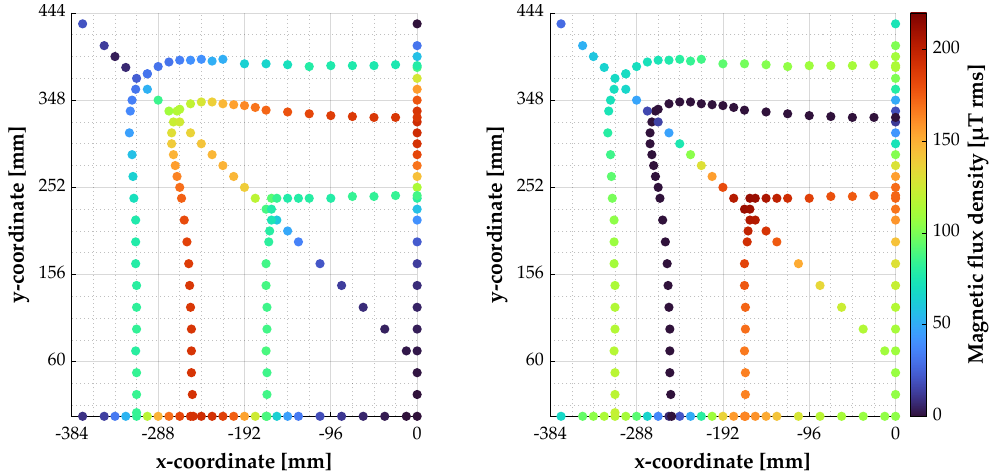
Figure 3. Magnetic flux density of the magnetic field of the ground assembly at a current of 4Arms ( left ) Component in the xy -plane ( right ) z